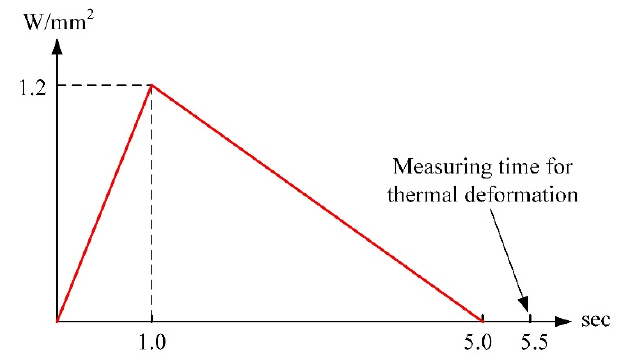
Figure 12. Heat flux loading on the sliced rotor model.